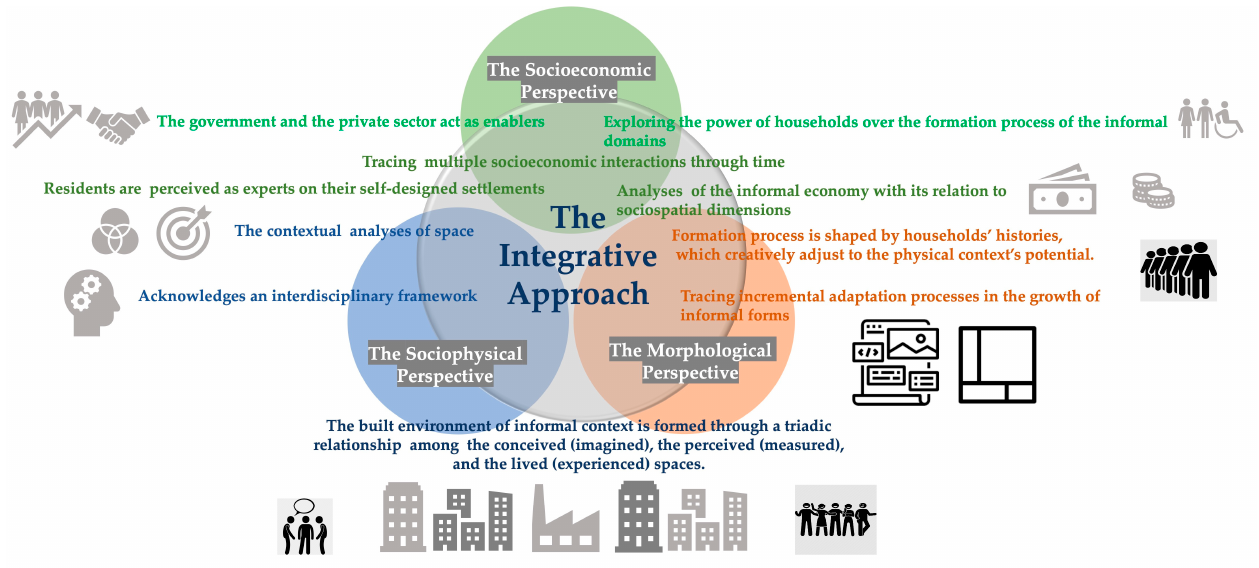
Figure 5. The integrative model for understanding the mechanism of informal settlement formation.